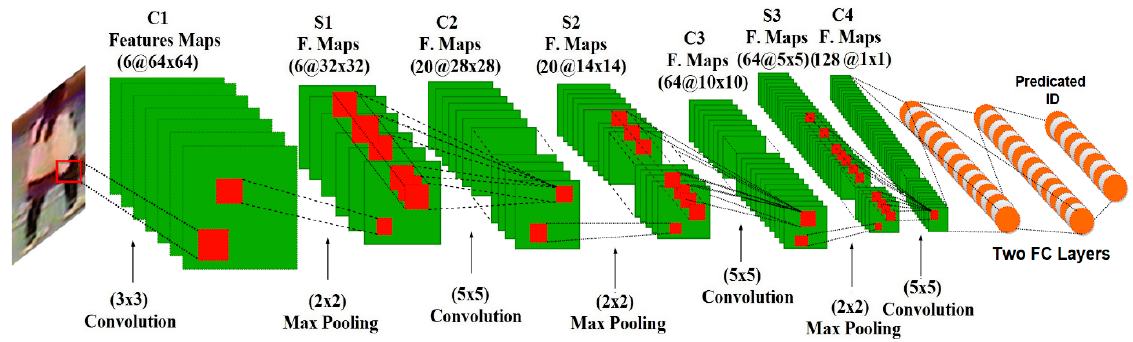
Figure 3. The architecture of the developed CNN model for addressing person ReID problems.